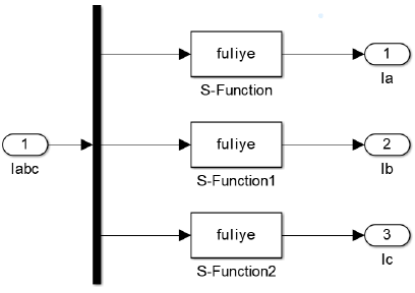
Figure 6: Composition of subsystem